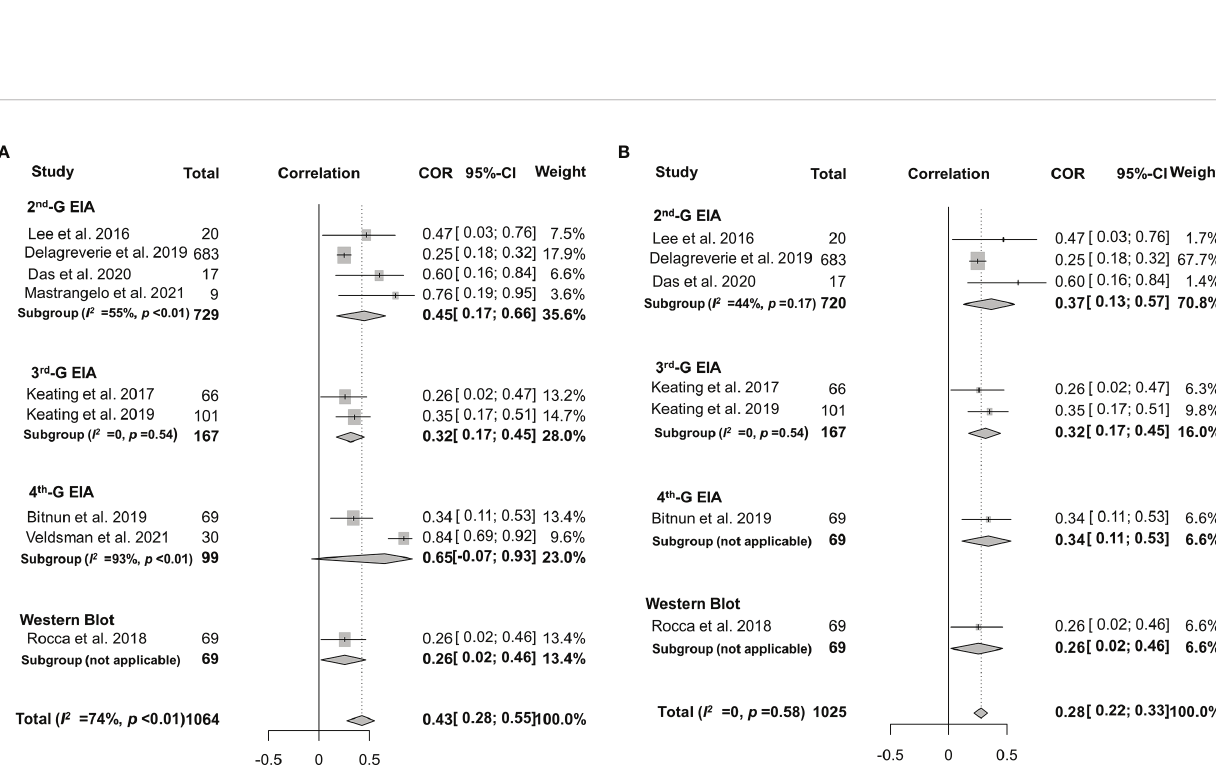
FIGURE 6 | Forest plots of the pooled Spearman ’ s correlation coef fi cient (rho) with the corresponding 95% CIs for the correlation between HIV-1-speci fi c antibody titer and HIV-1 DNA burden in patients for all the eligible studies (A) or the studies without signi fi cant heterogeneity (B)